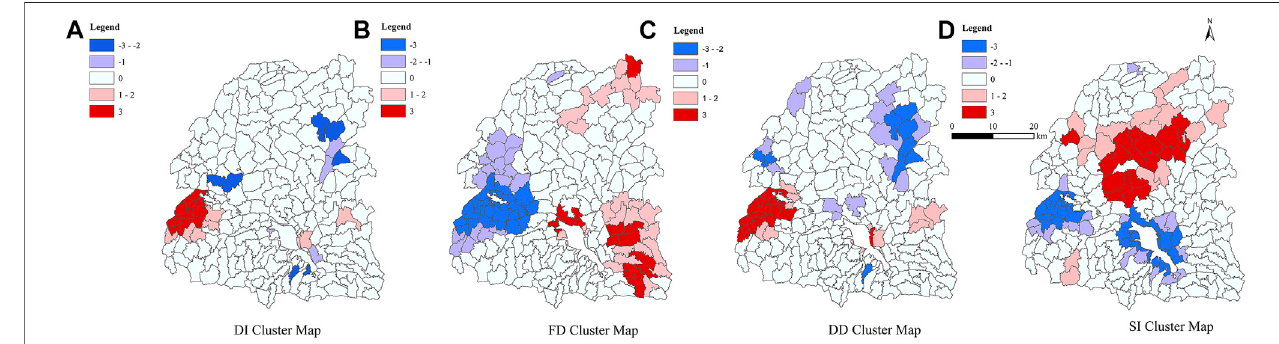
FIGURE 5 | analysis of hot spots and cold spots of the landscape index of